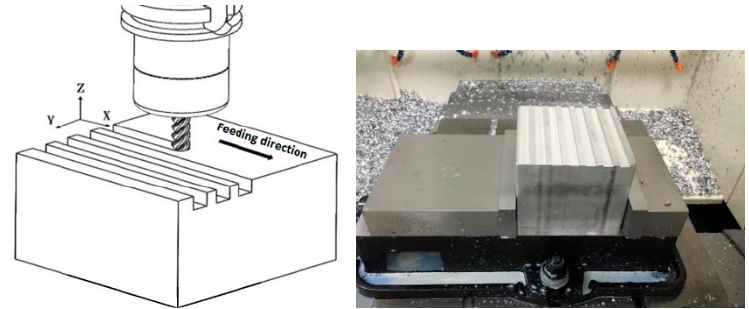
Figure 4. Machining test and workpiece.